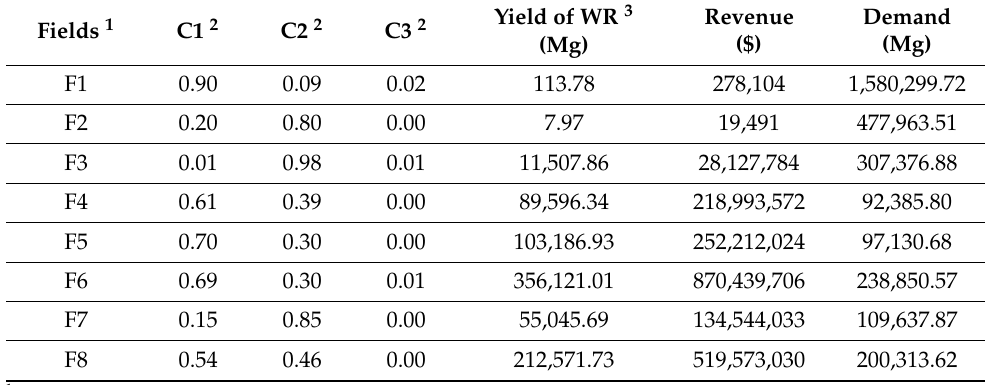
Table 9. Attractiveness weight and demand for rice paddy fields.